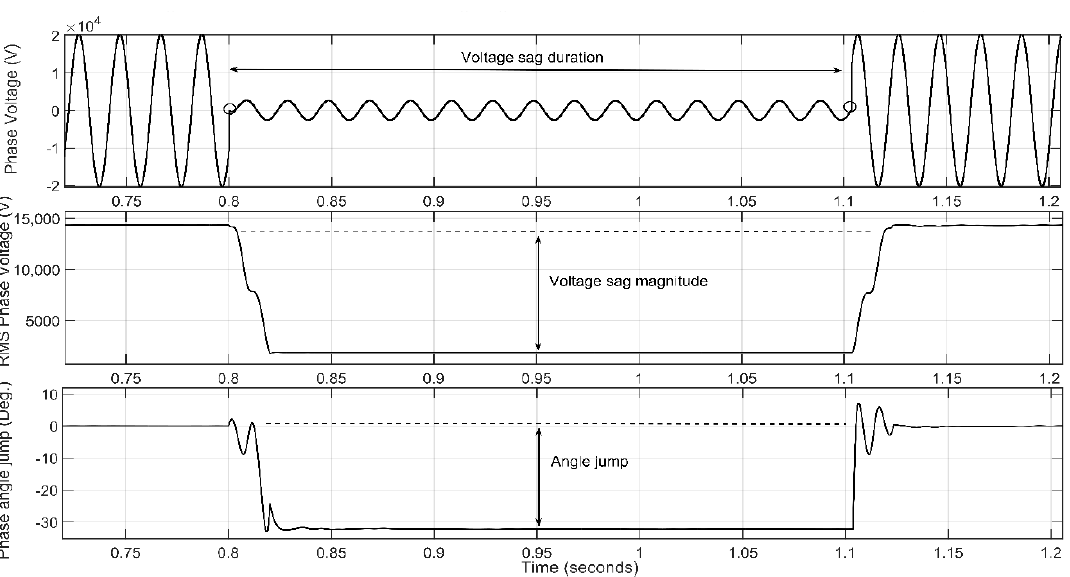
Figure 1. Example of a constant voltage sag produced by a single-line-to-ground (SLG) fault and its characteristics.